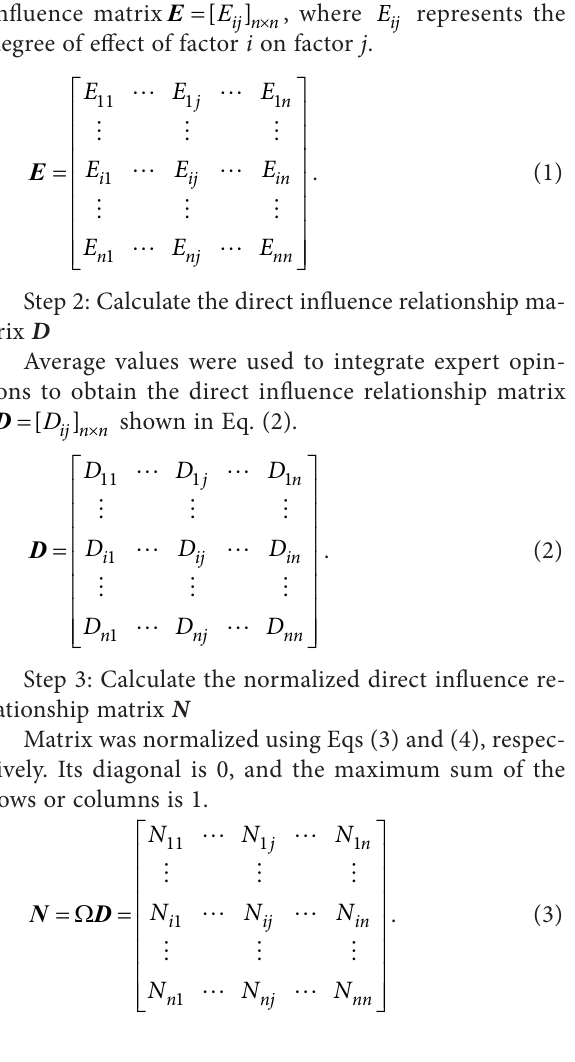
Table 2. Total influential effect matrix T of